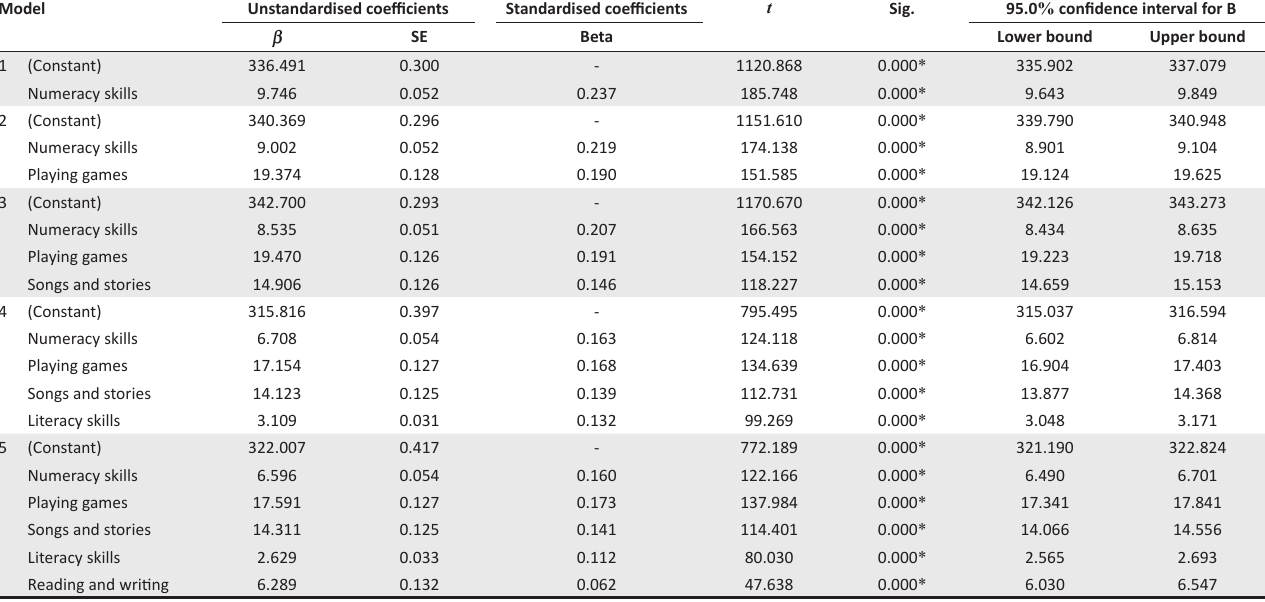
TABLE 5: Results of a stepwise regression analysis showing the association between early learning activities at home, pre-Grade 1 literacy and numeracy skills, and mathematics performance.